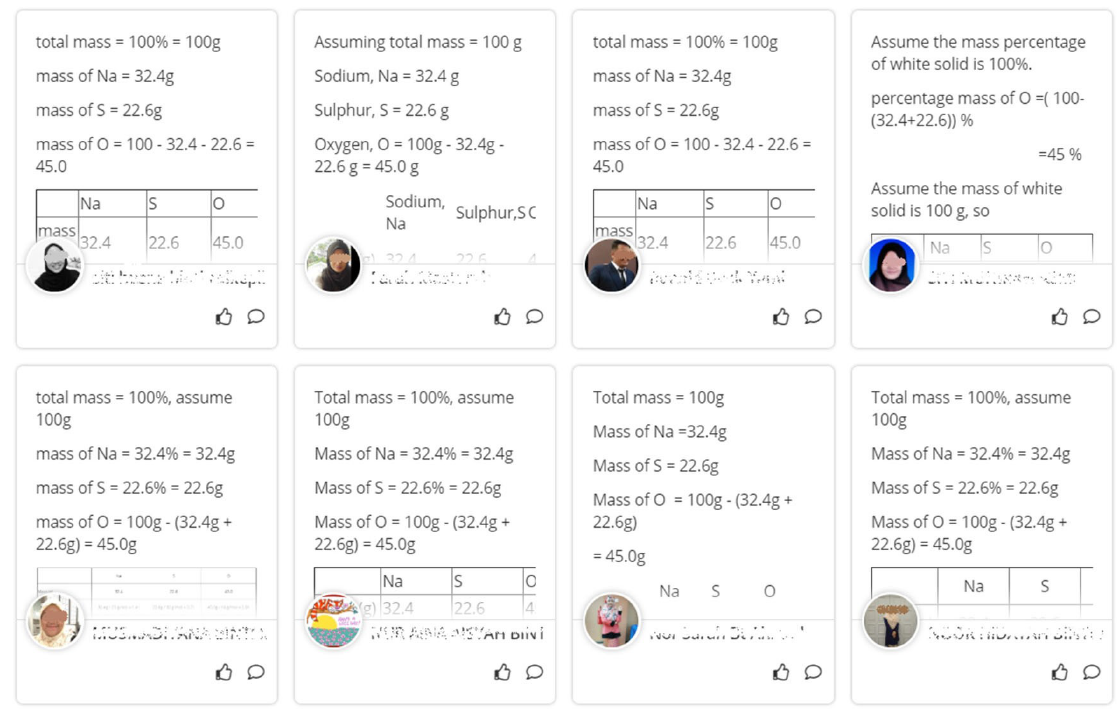
Figure 6. Examples of answers shared by students